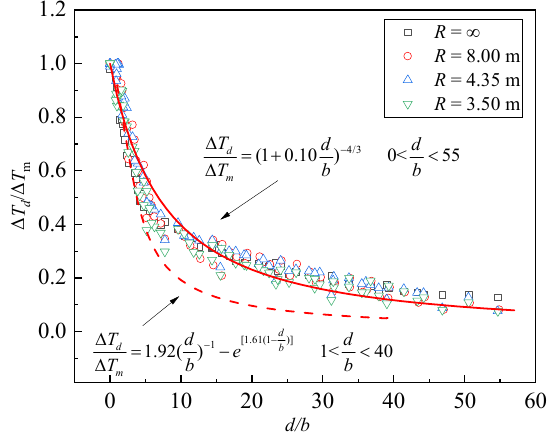
Figure 10. Prediction correlation of longitudinal attenuation of temperature below a ceiling for a scenario with a strong plume-driven ceiling jet.